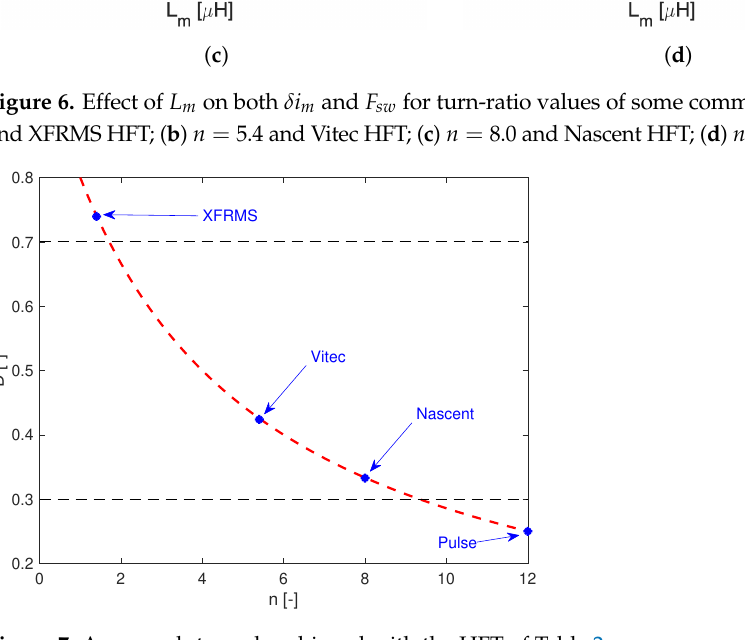
Figure 7. Average duty cycle achieved with the HFT of Table